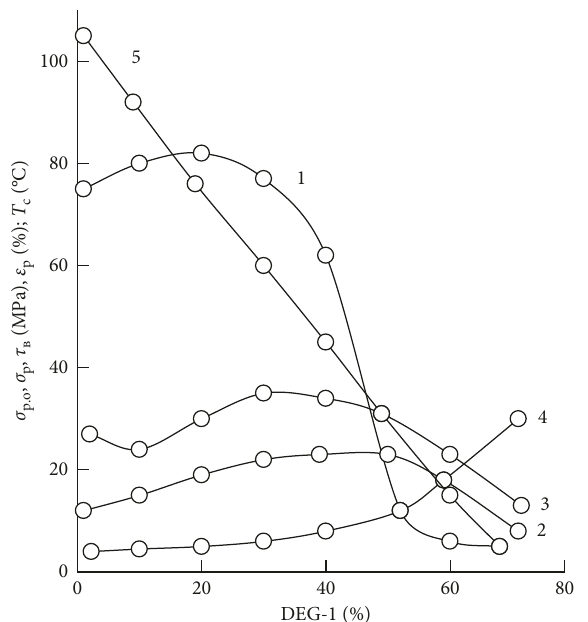
Figure 10: The effect of the DEG-1 content in the composition of ED-20+ DEG-1+DETA on the properties of polymers: σ r (1), τ c (2), σ r .o (3), ε r (4), and T s (5).